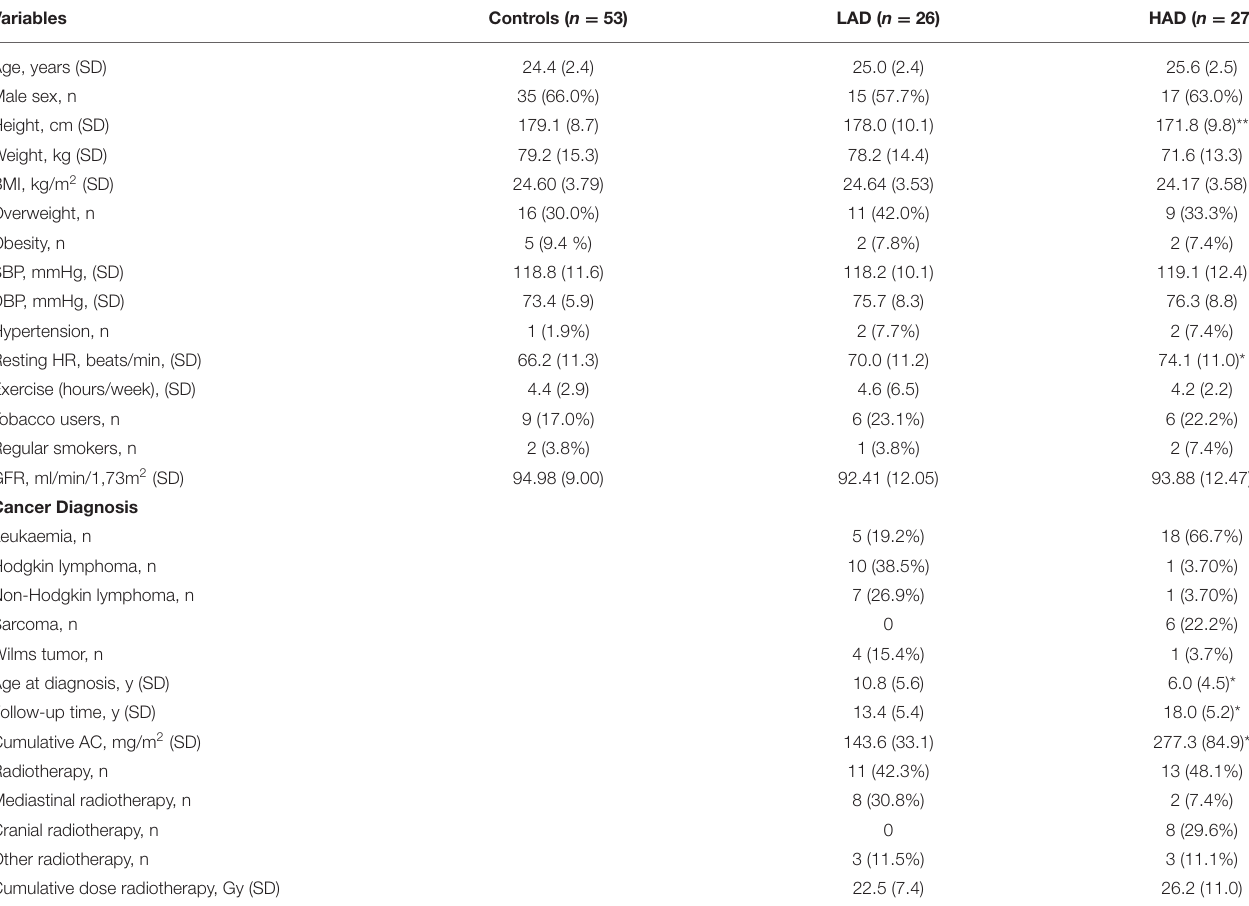
TABLE 1 | Characteristics of the study cohort divided in subjects with low (LAD) or high (HAD) cumulative dose of anthracyclines.